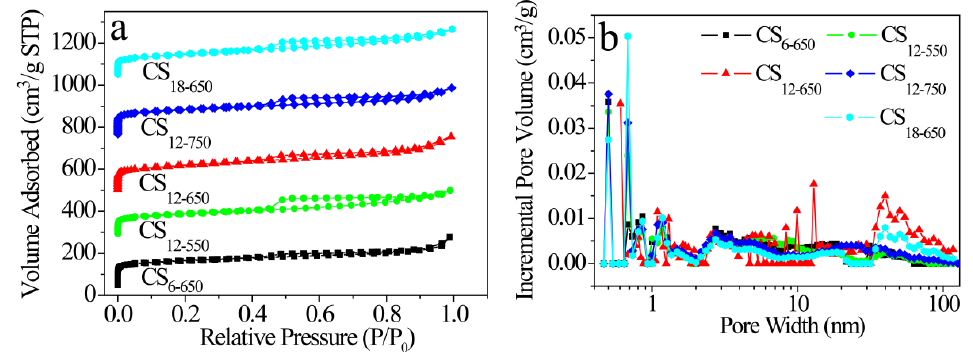
Figure 3. N 2 adsorption and desorption isotherms ( a ) and density functional theory (DFT) pore size distribution ( b ) of CSs.